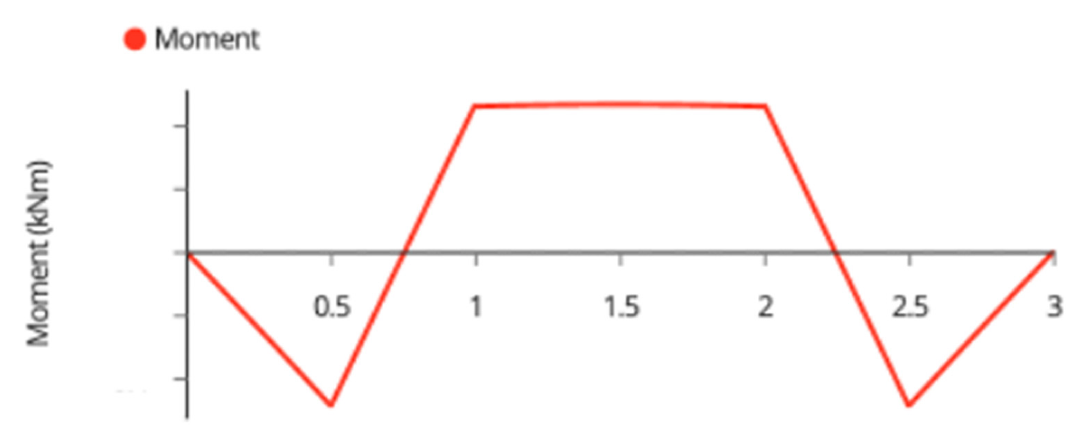
Figure A7. Beam Bending Moment Diagram.